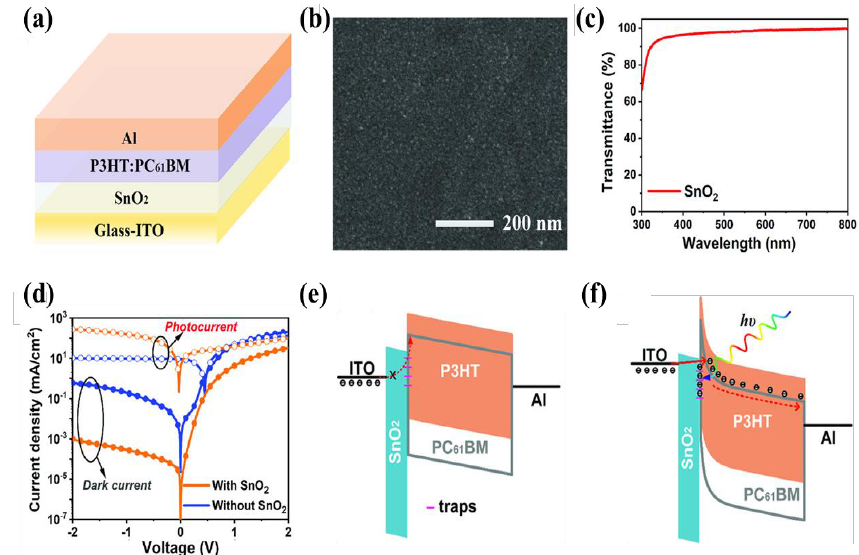
Figure 12. ( a ) Schematic diagram of the photodetector structure; ( b ) SEM image of the non-thermal-and-non-UVO-treated SnO 2 film; ( c ) Transmittance spectrum of the SnO 2 -coated glass substrates; ( d ) Photocurrent and dark current densities of the devices; The energy band structures of the devices under an applied reverse bias: ( e ) under dark; ( f ) under light. (Reproduced with permission from [107]. WILEY Publishing, 2019).